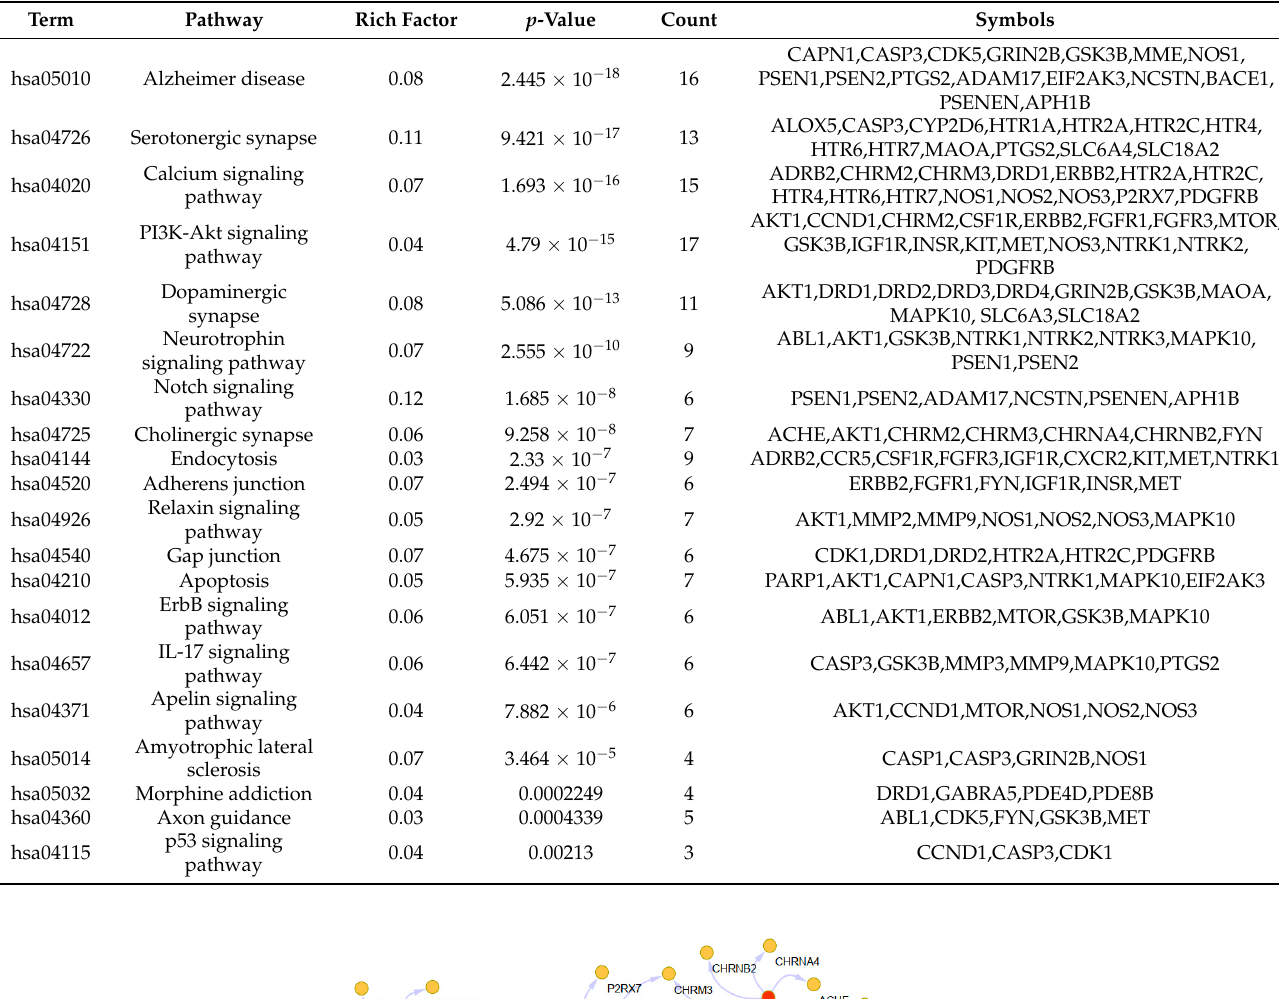
Table 3. Top 20 KEGG pathway terms enriched in UR alkaloids against AD.